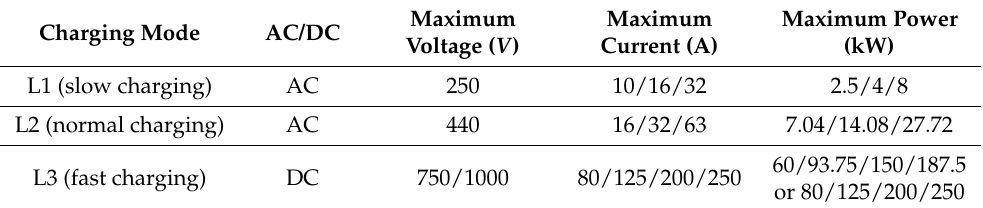
Table 1. Different EV charging modes according to national standard of China GB/T